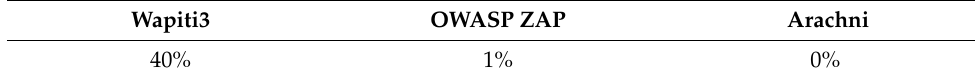
Table 5. Coverage percentage for non-commercial tools.